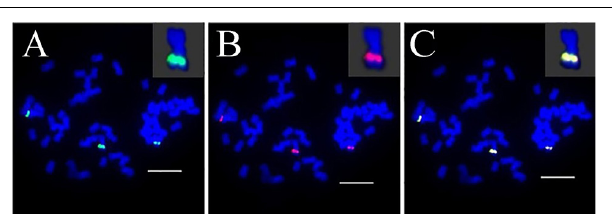
FIGURE 6 | FISH mapping of BAC-2, 45srDNA on SsChr3 in S. spontaneum . (A) BAC-2 labeled with biotin (green); (B) 45s rDNA probes labeled with digoxigenin (red). (C) Merged images of (A) and (B) . Scale bars = 10 µ